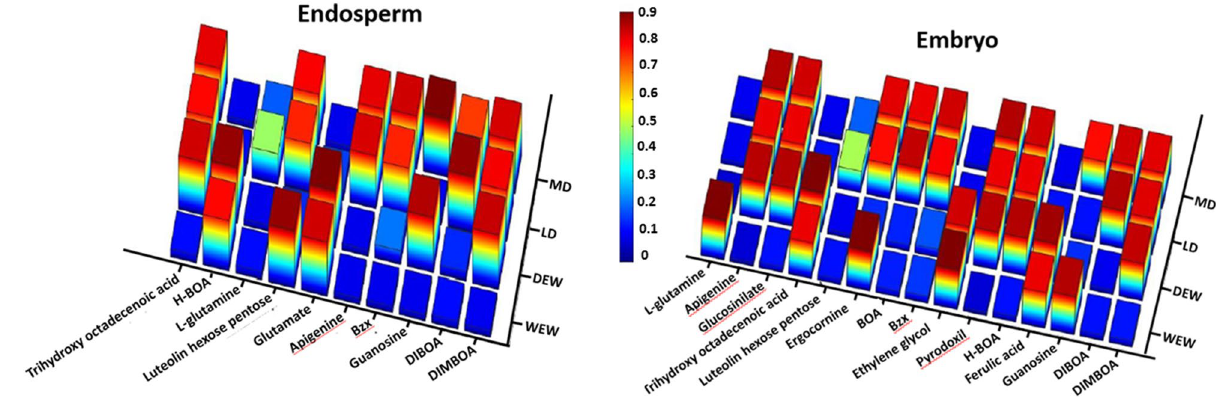
Figure 4. Changes in normalized benzoxazinoids metabolites-natural antibiotic metabolites profile during tetraploid wheat domestication in the ( A ) endosperm and ( B )